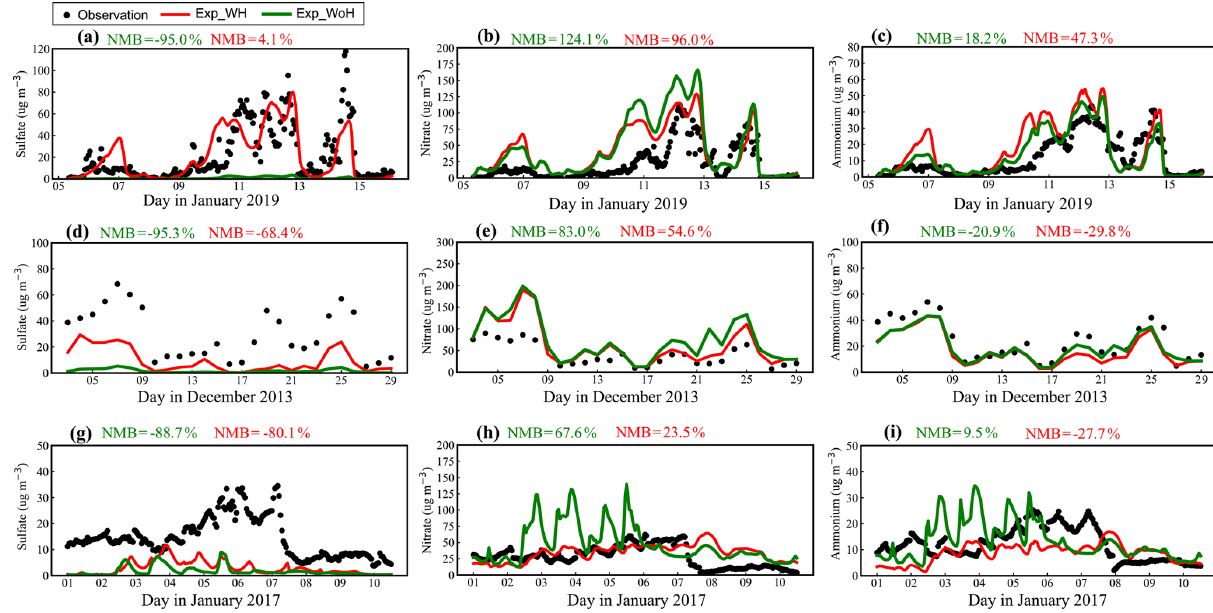
Figure 5. Observed and simulated hourly SIA concentrations from the Exp_WH and Exp_WoH experiments at the (a–c) Langfang, (d– f) Nanjing, and (g–i) Chengdu sites.